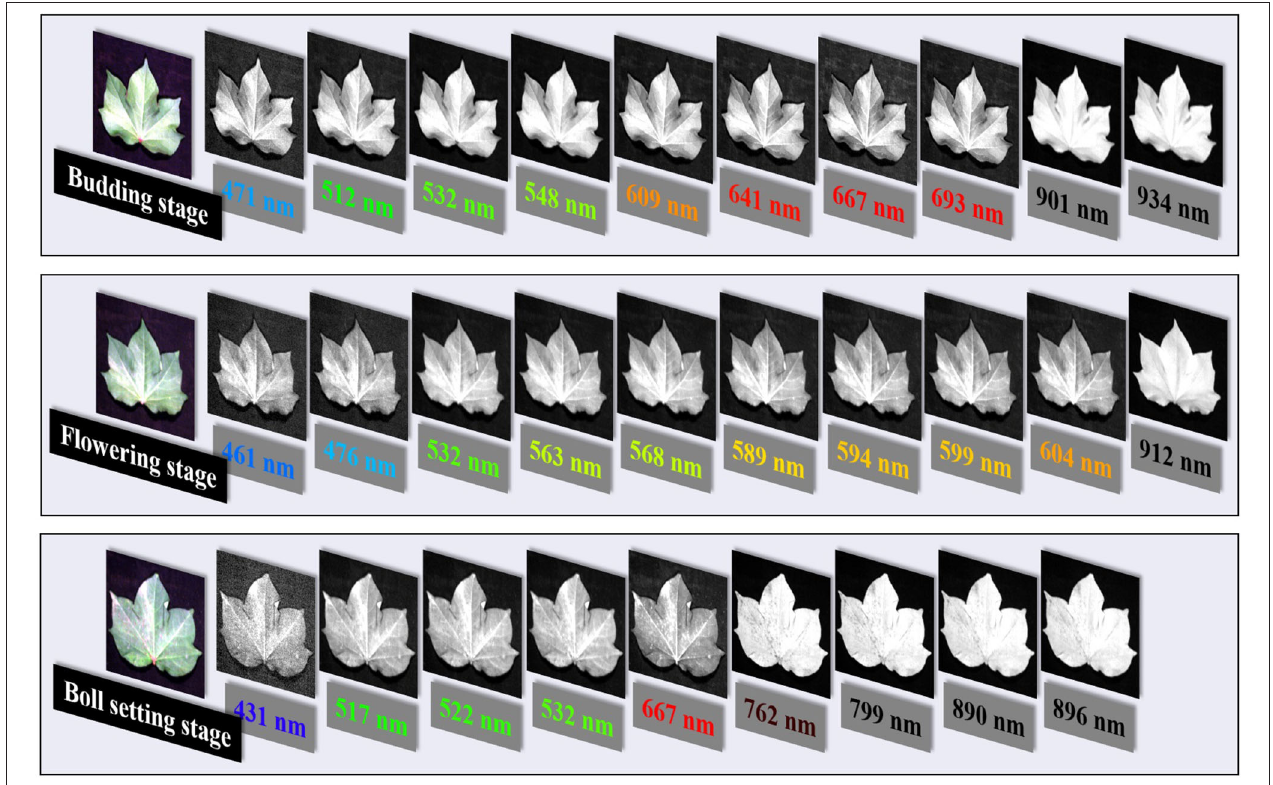
FIGURE 8 | Characteristic wavelength grayscale image databases based on CWT-1, CWT-3, and CWT-9 wavelet coefficients.